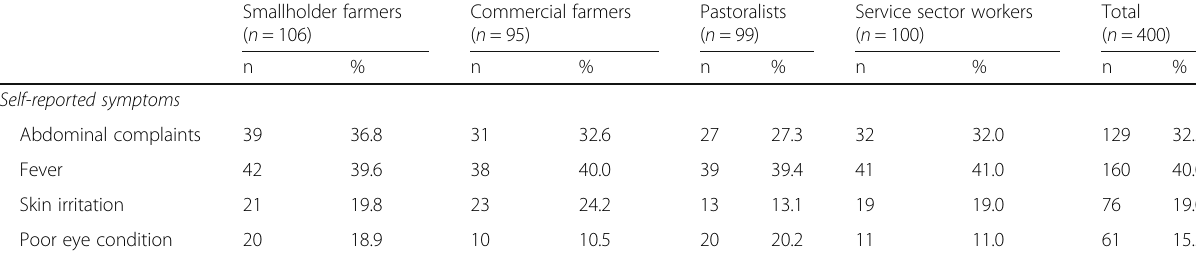
Table 4 Self-reported symptoms in four week recall period, stratified by user